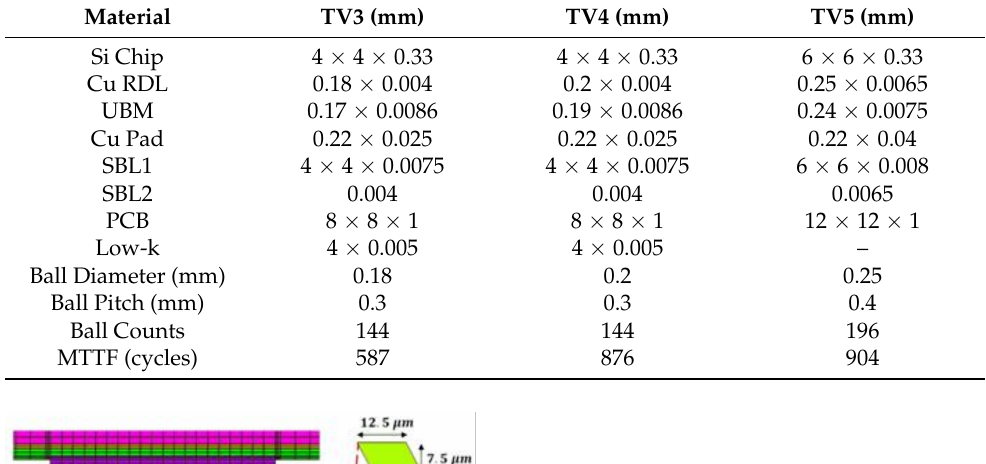
Table 2. Dimension of WLP TV3, TV4 and TV5.